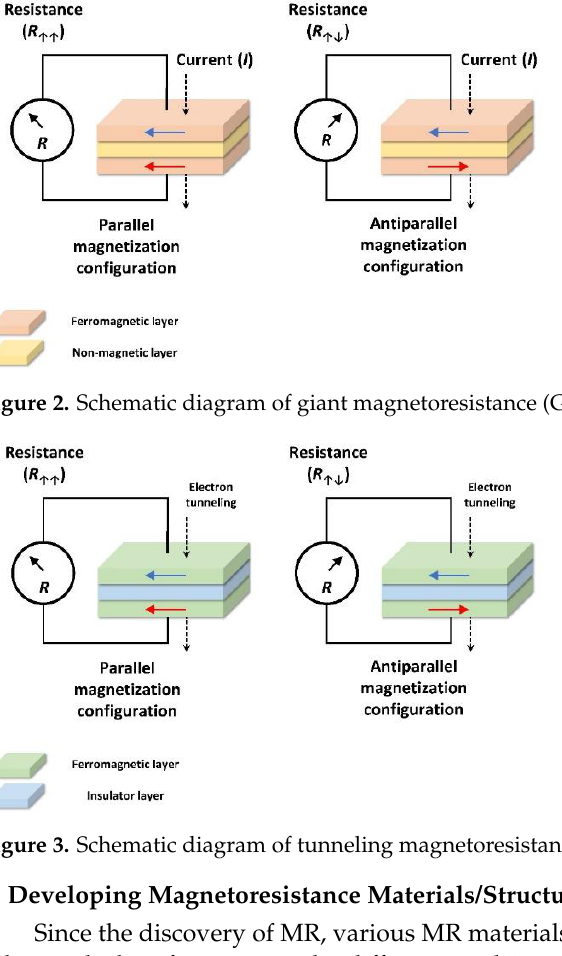
Figure 2. Schematic diagram of giant magnetoresistance (GMR).